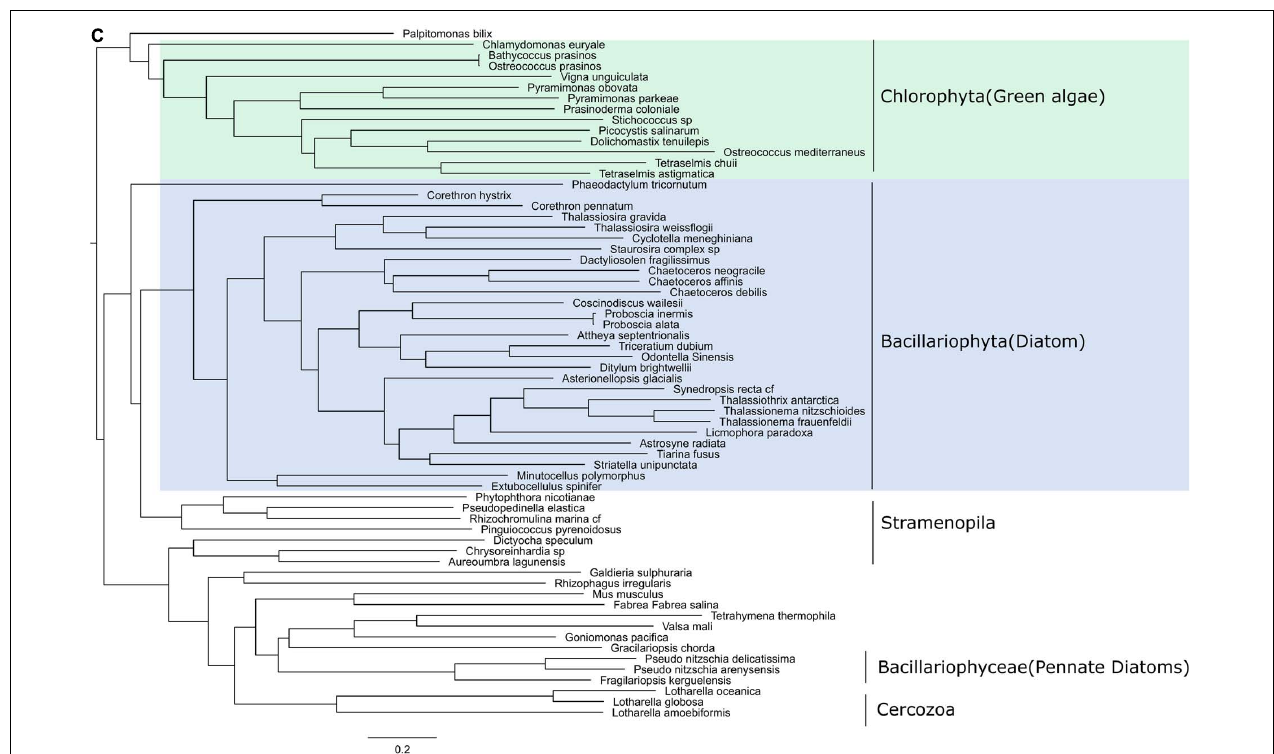
FIGURE 2C | Phylogenetic trees of PRC1 components. (A) RING, (B) Psc, (C) Pc.